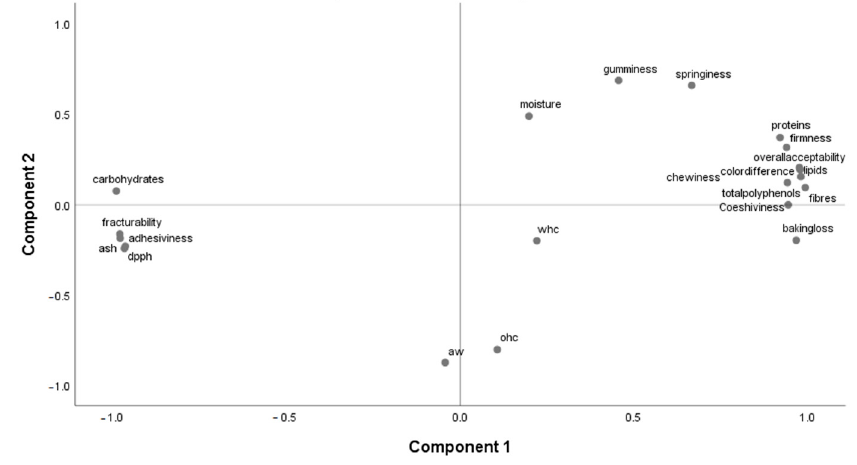
Figure 4. Principal component analysis.